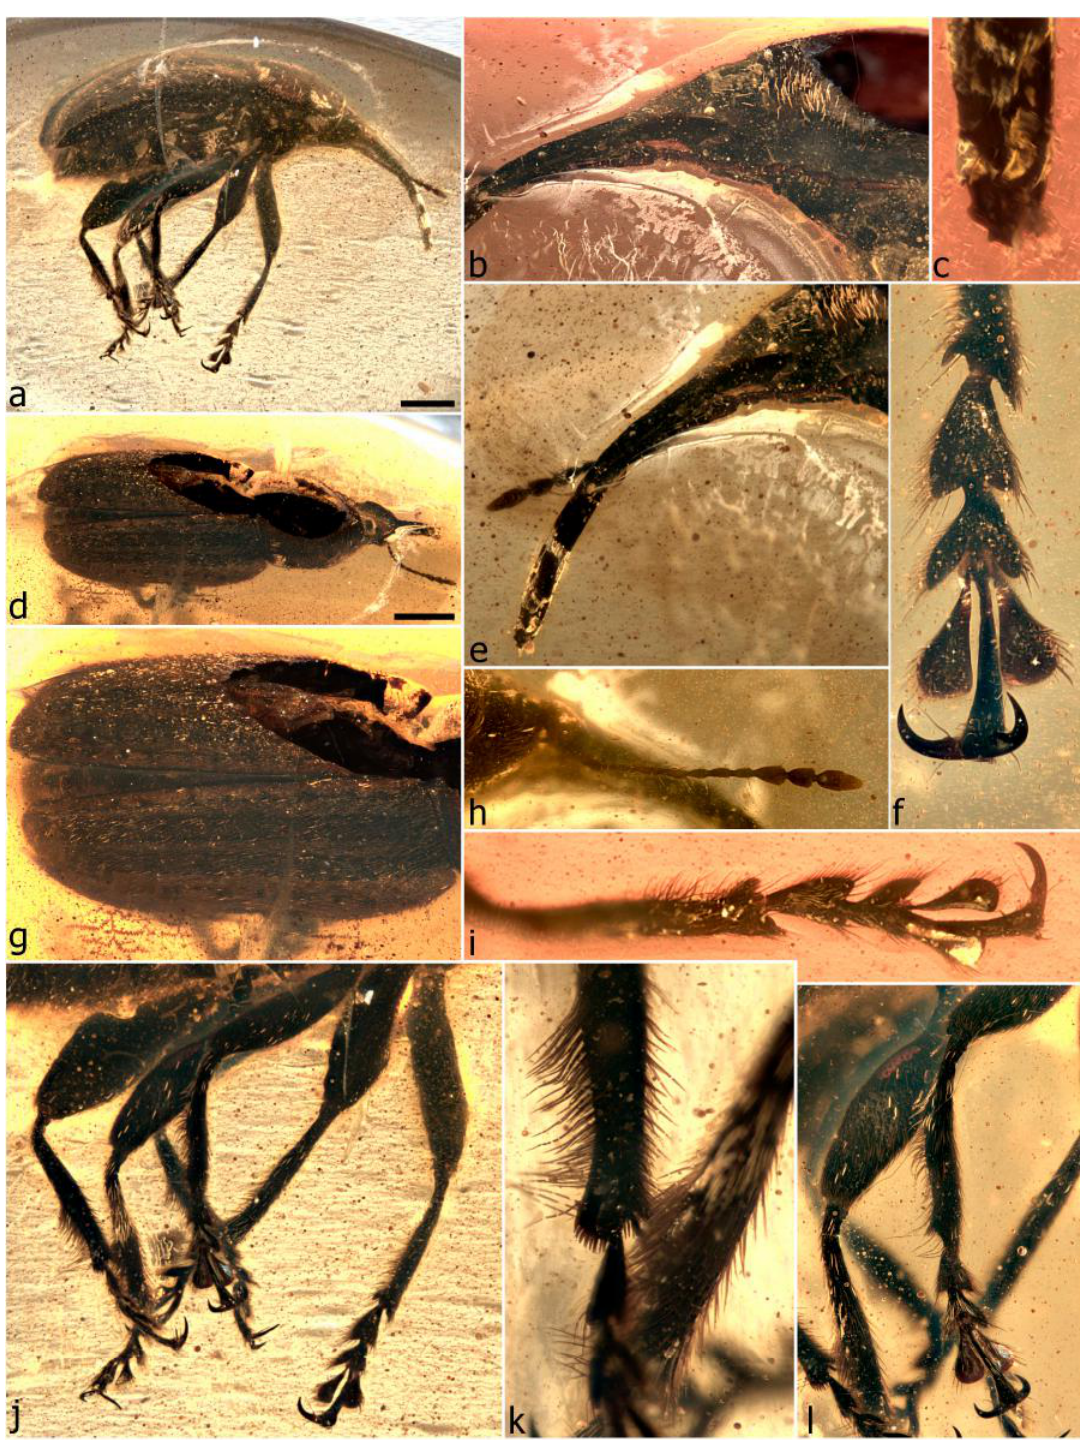
Figure 43. Opeatorhynchus comans sp. n., holotype. Habitus, lateral ( a ); head and prothorax, left lateral ( b ); mandibles, dorsal ( c ); habitus, dorsal ( d ); head and antenna, left lateral ( e ); protarsus, dorsal ( f ); elytra, dorsal ( g ); right antenna ( h ); left protibibia and -tarsus ( i ); legs, lateral ( j ); metatibia, showing dense setae in emargination of outer side ( k ); middle leg, dorsal ( l ). Scale bars: 1.0 mm (a,d). Material examined. Holotype (NIGP154217) (probably a male): extremely well preserved and well visible specimen, largely intact but with left side of pronotum, anterior half of left elytron, scutellar shield and part of left protarsal claw partly cut away during preparation, subsequently infilled